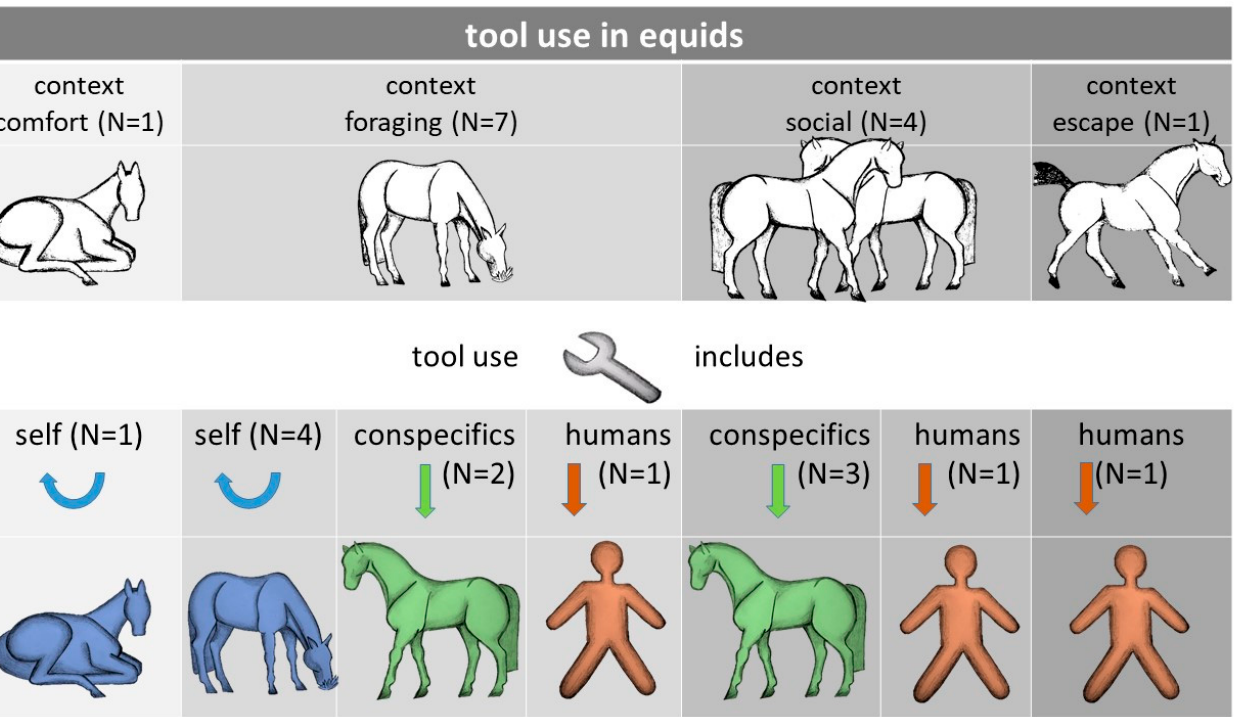
Figure 2. Tool use context and direction in horses. Blue colouration indicates that tool use was solitary ( n = 5), green colouration that tool use included a conspecific ( n = 5), and brown colouration that it included humans ( n = 3).